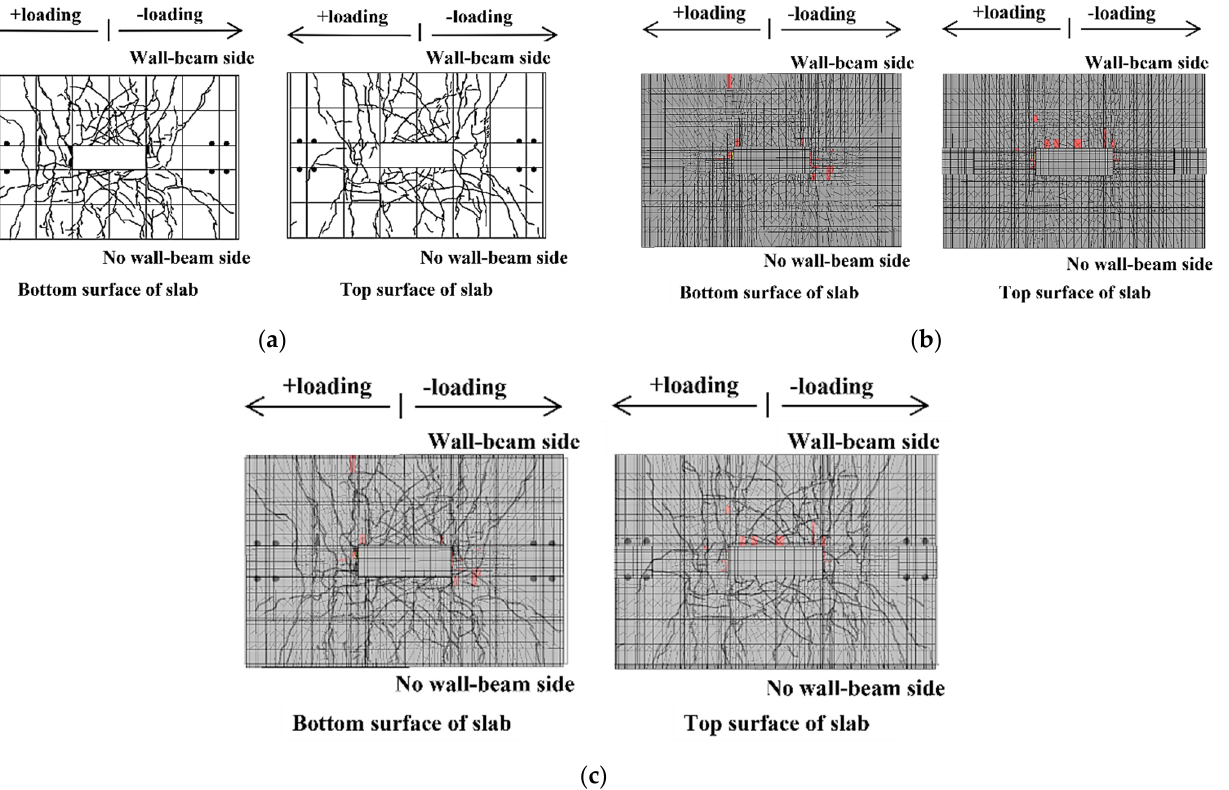
Figure 16. Crack pattern comparison of experimental and FEM results for Model 1: ( a ) Experimental test results [11,12]; ( b ) FEM analysis results; and ( c ) comparison.